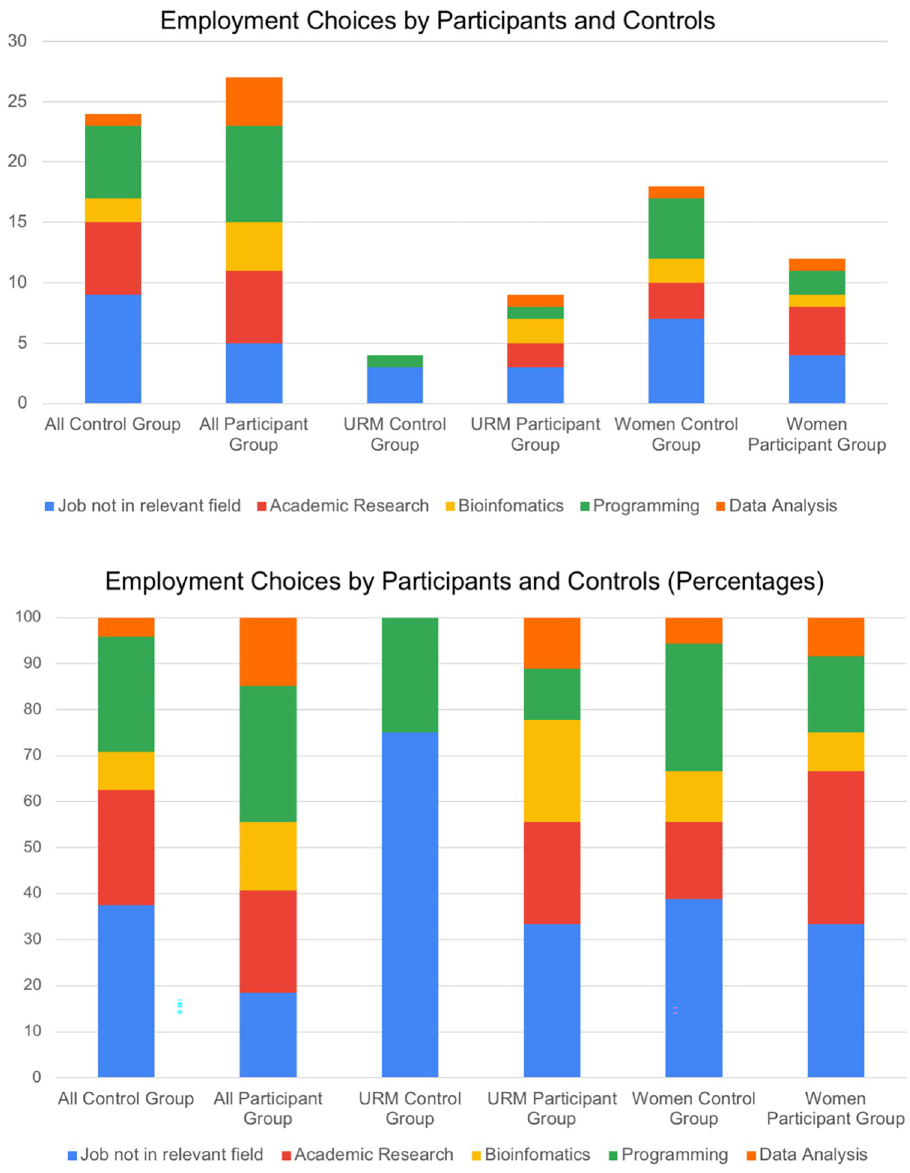
Fig 7. Comparison of types of jobs pursued by BIG Summer participants and controls. Surveys and web-based searches were used to determine the types of jobs held by BIG Summer alumni and controls. Data are shown for all students (A), underrepresented minorities (B), and women